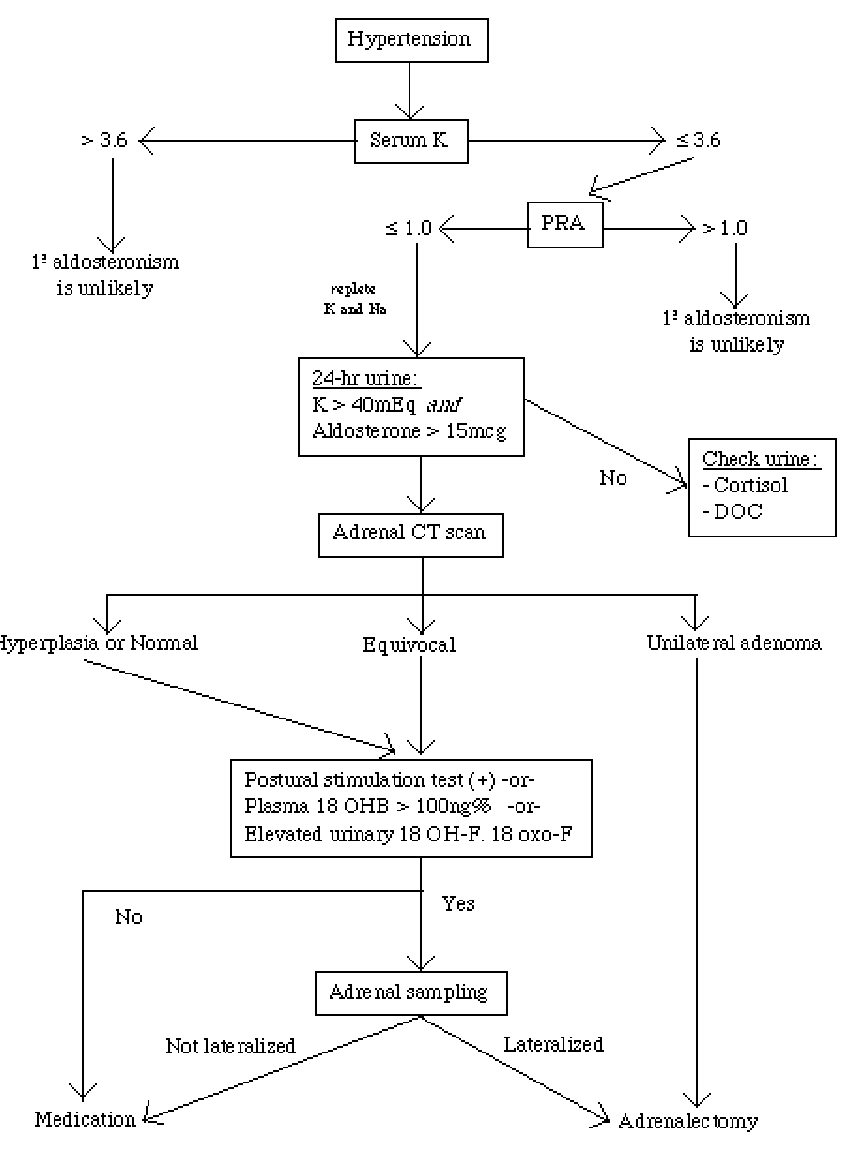
FIGURE 5 . (From: Blumenfeld JD, Sealey JE, Schlussel Y, et al.: Dignosis and treatment of primary hyperaldosteronism. Ann Intern Med., 121:877-885,